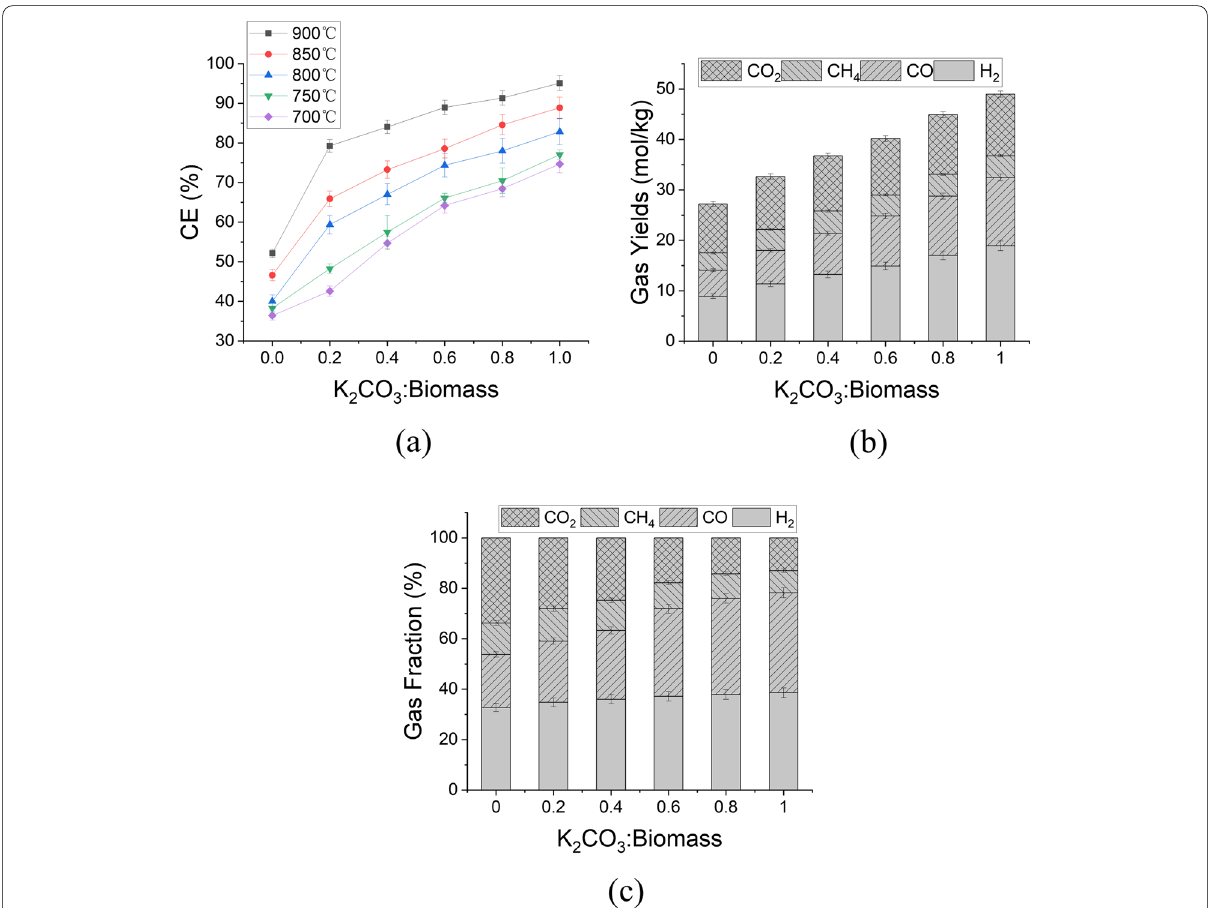
Fig. 6 Effect of K 2 CO 3 (mechanical mixing) on the supercritical carbon dioxide gasification of biomass (900 °C; 30 min): a CE; b gas yields of biomass gasification; c composition of the gas